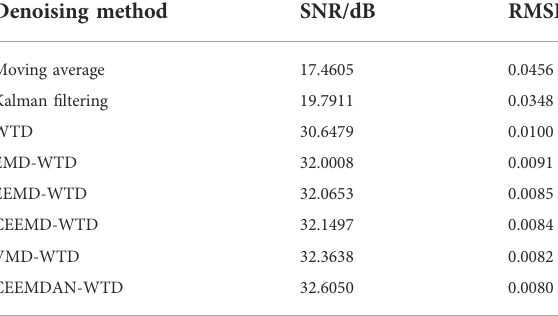
TABLE 2 SNR and RMSE results after applying various denoising methods. Denoising method